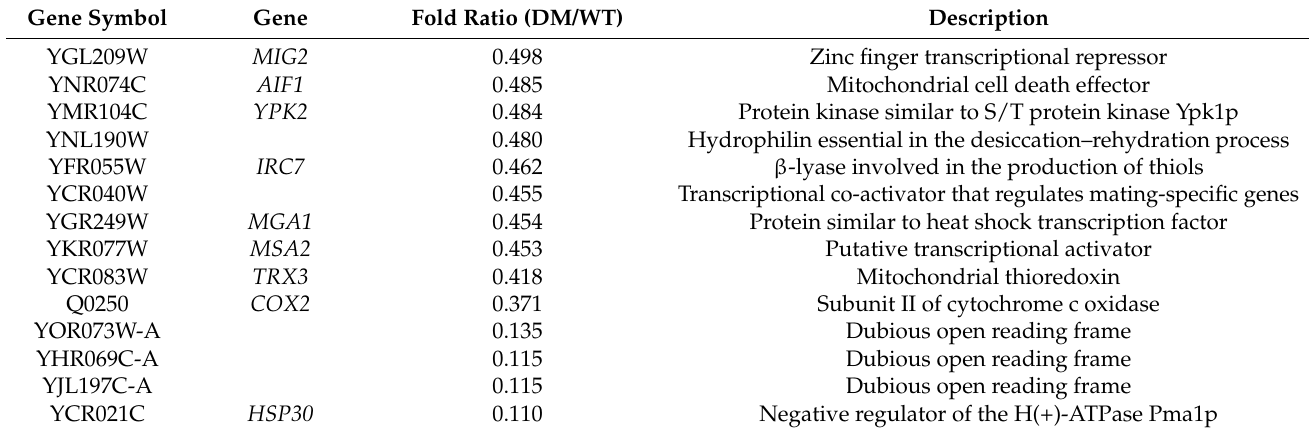
Figure 5. ClueGO-based genetic network of downregulated genes in DaMDHAR -expressing yeast cells under repeated FT (FT2) stress. Table 2. Downregulated genes in DaMDHAR -expressing yeast cells to FT stress.